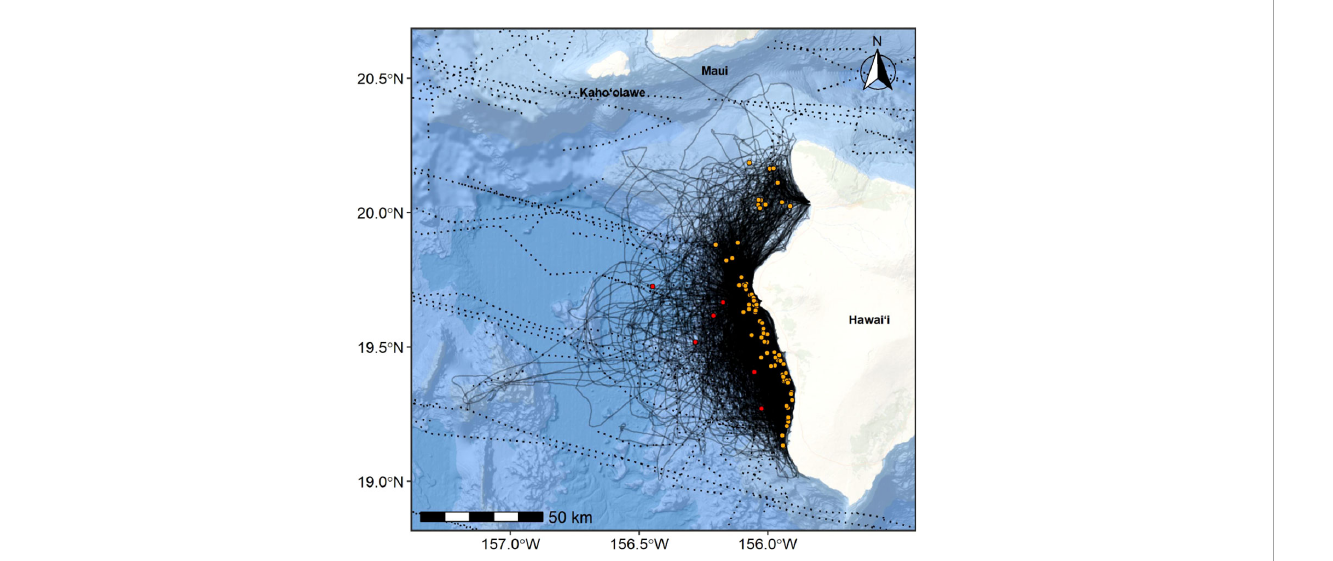
FIGURE 1 Dwarf sperm whale sighting locations (n=89) off Hawai ʻ i Island overlaid on research vessel tracklines (CRC = solid lines, NMFS = dotted lines) from efforts conducted during 2002-2021 (97,438 km of effort CRC and 3,717 km of effort NMFS). Six sightings deeper than 2,000 m depth (included here, shown in red circles) were excluded from the BIA boundary determination as they were likely part of a broader pelagic population ( fi nal sample size = 83, orange circles; Baird et al., 2021c). Basemap image is the intellectual property of Esri and is used herein with permission. Copyright © 2022 Esri and its licensors. All rights